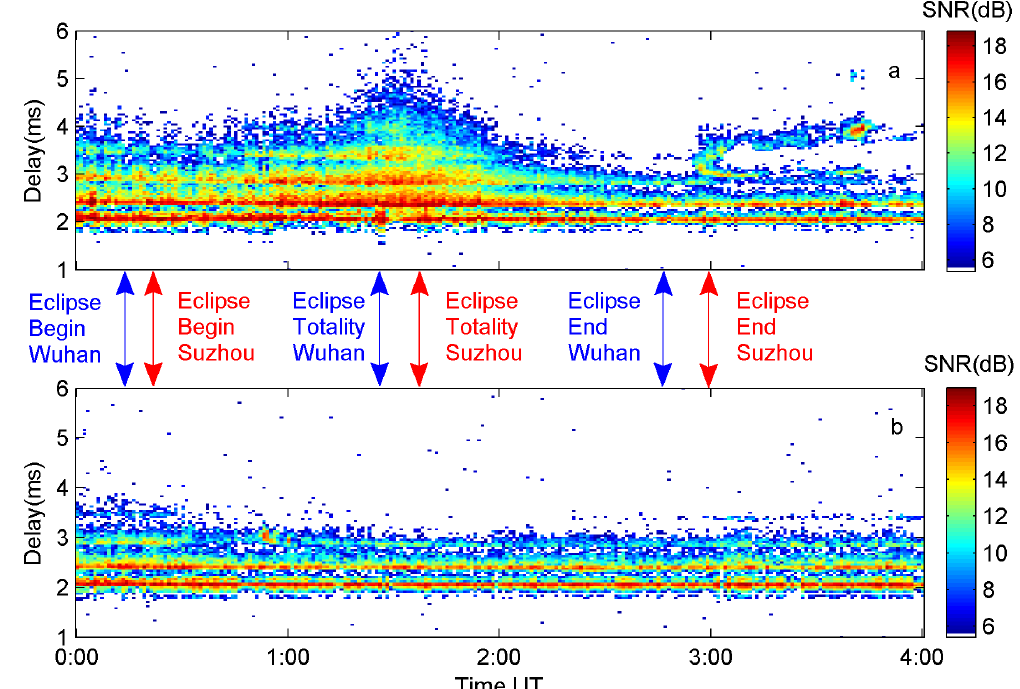
Fig. 2. The delay-time oblique ionograms of Wuhan-to-Suzhou line. Panels (a) and (b) are the echoes recoded at 6.6MHz operating frequency in the morning of 22 and 23 July, respectively. The solar eclipse time of Wuhan and Suzhou is marked on the figure.